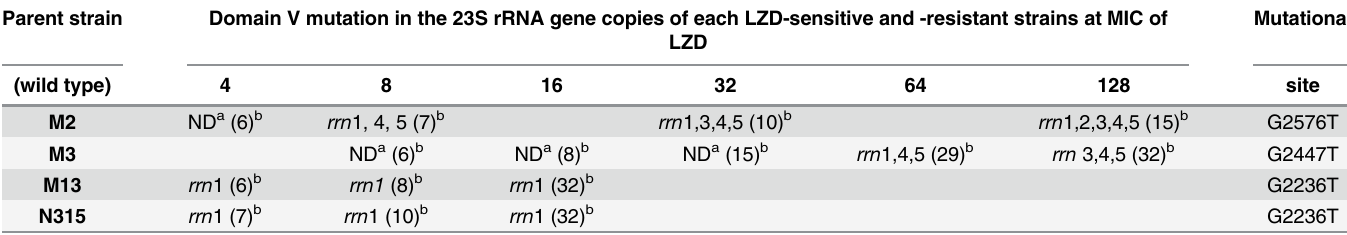
Table 5. Relationship of the presence of mutated domain V in the 23S rRNA genes with the level of LZD resistance Parent